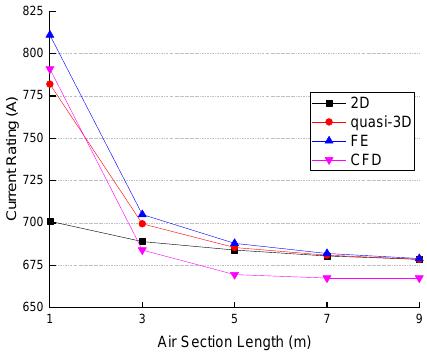
Figure 5. Ratings for different air section lengths.